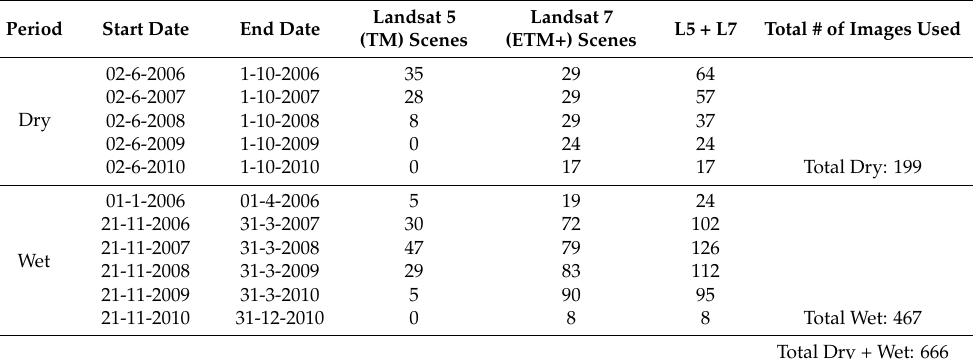
TM: Thematic Mapper. ETM: Enhanced Thematic